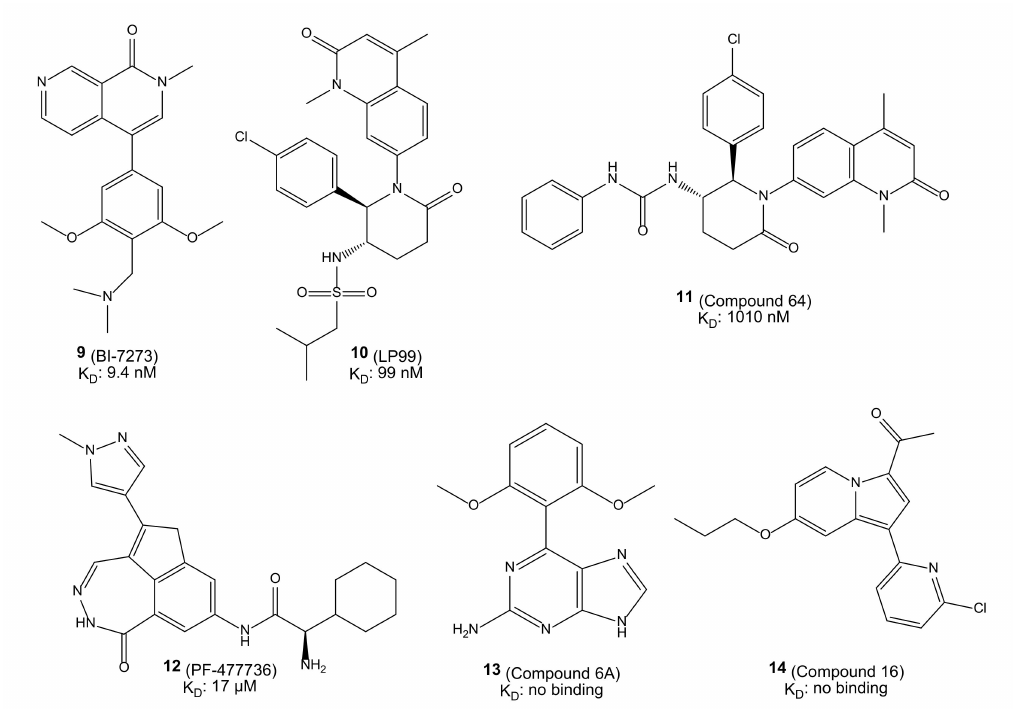
Figure 10. Chemical structures and K D values of the six compounds 9 – 14 used in the test